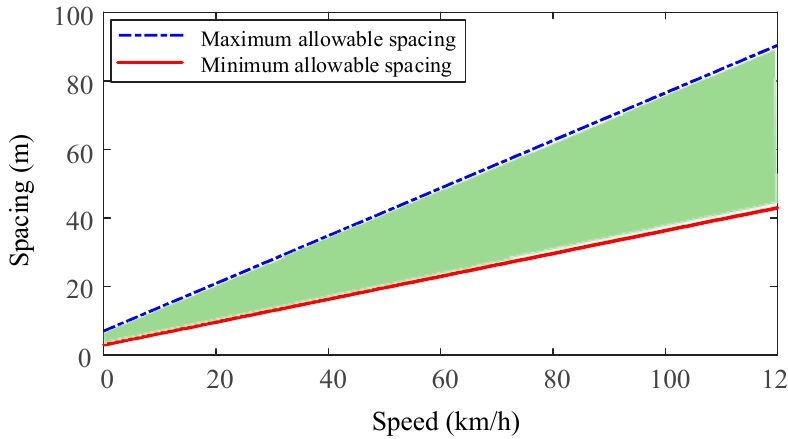
Figure 7. Longitudinal car-following distance.